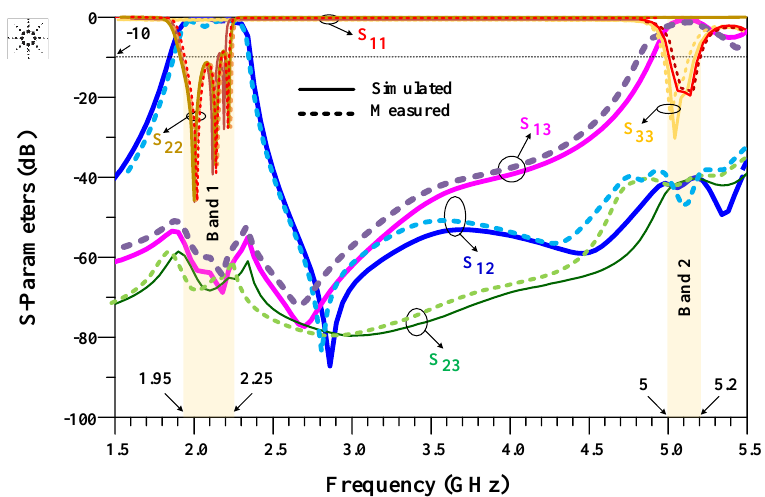
Figure 13. Simulations and measurements of S-parameters results of the fabricated diplexer.